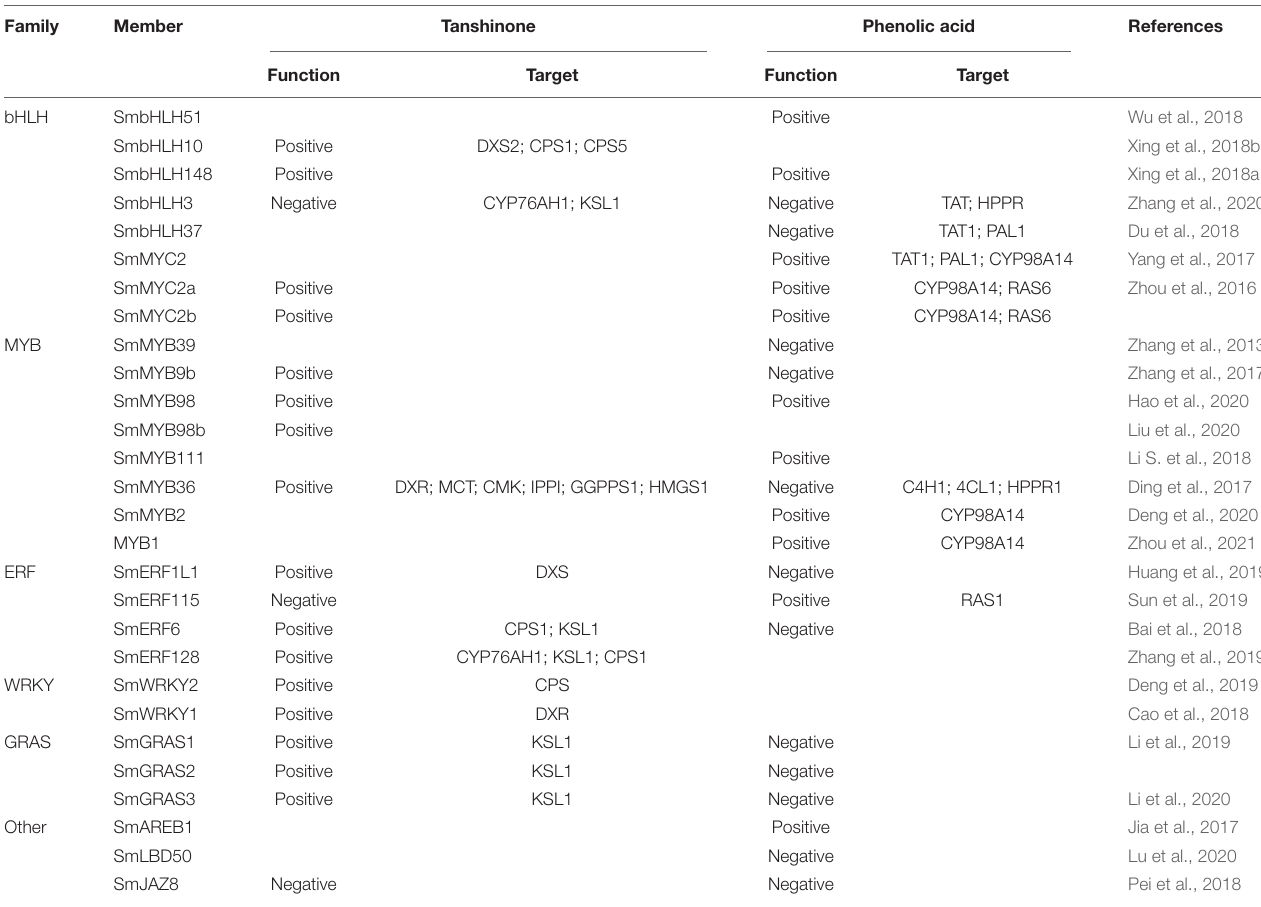
TABLE 1 | TFs positively or negatively regulate ingredients in S. miltiorrhiza